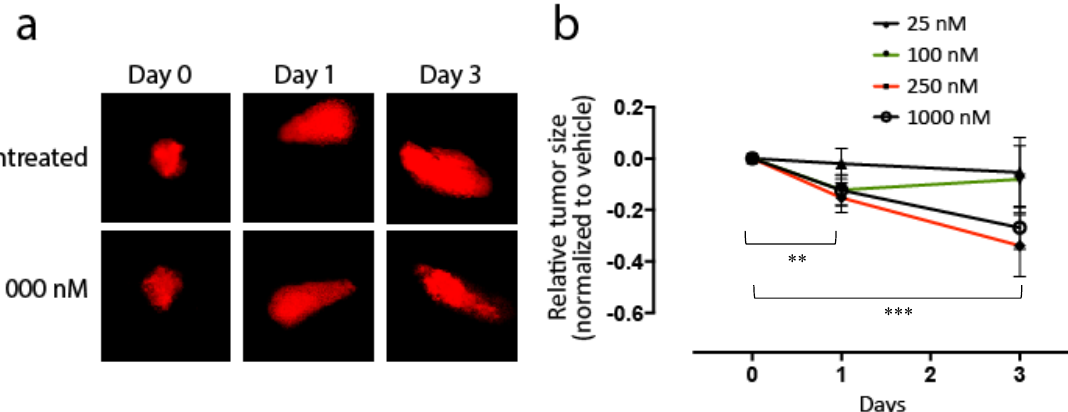
Figure 5. Zebra fish embryos were transplanted with the OCI-Ly3 cell line and treated with KAN0441571C for three days. ( a ) Photographs of only the tumor area days 0, 1 and 3 in zebra fishes transplanted with stained OCI-Ly3 in untreated and 1000 nM treated zebra fishes. ( b ) Tumor size (ratio) (mean ± SEM) in KAN0441571C treated zebra fishes at days 0, 1 and 3. A total of 21